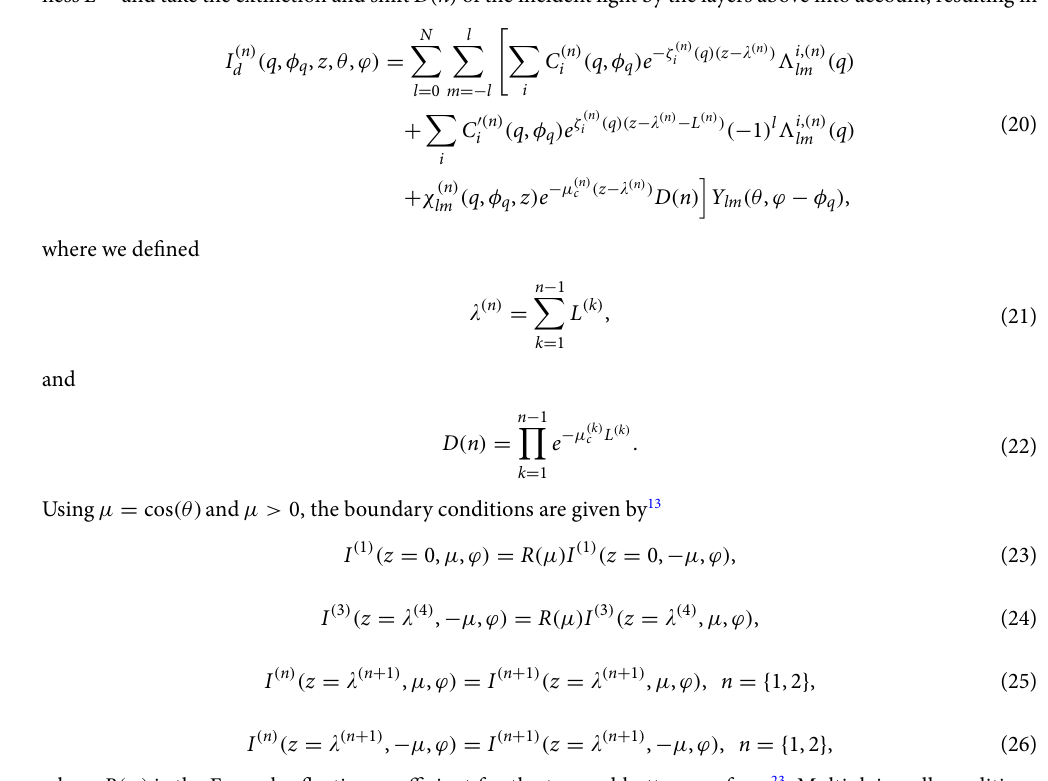
1, 2, 3 with thick- ∈ { }